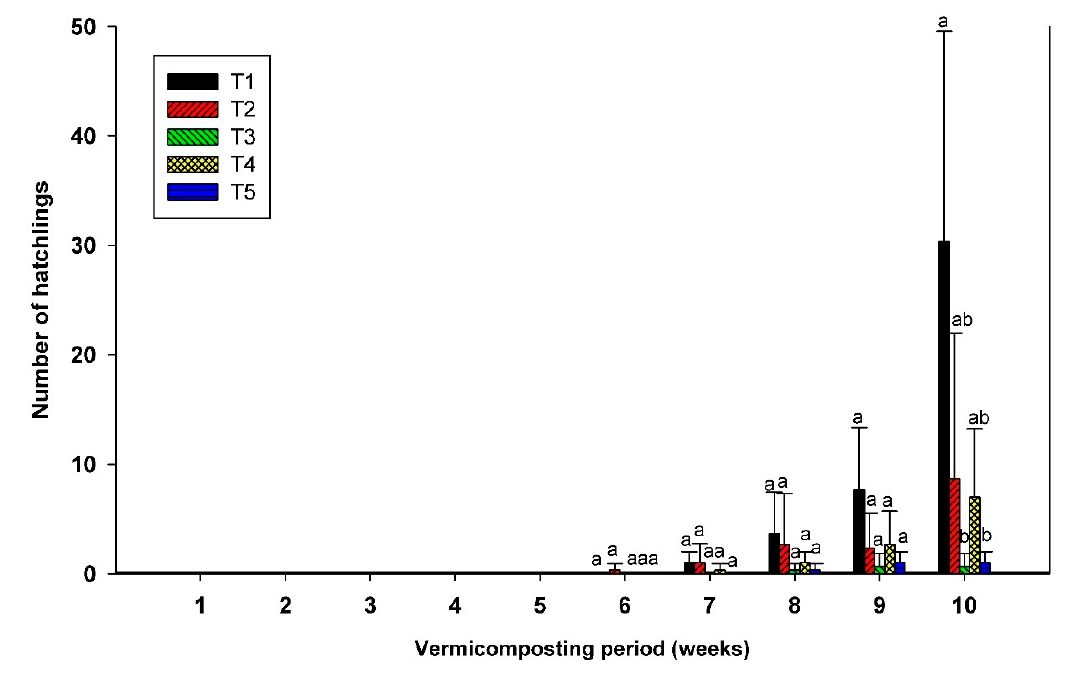
Figure 4. Mean ± SD values of the number of hatchlings followed by different letters in the same week are different in terms of statistical significance ( p -value < 0.05) between the combinations in- volved.